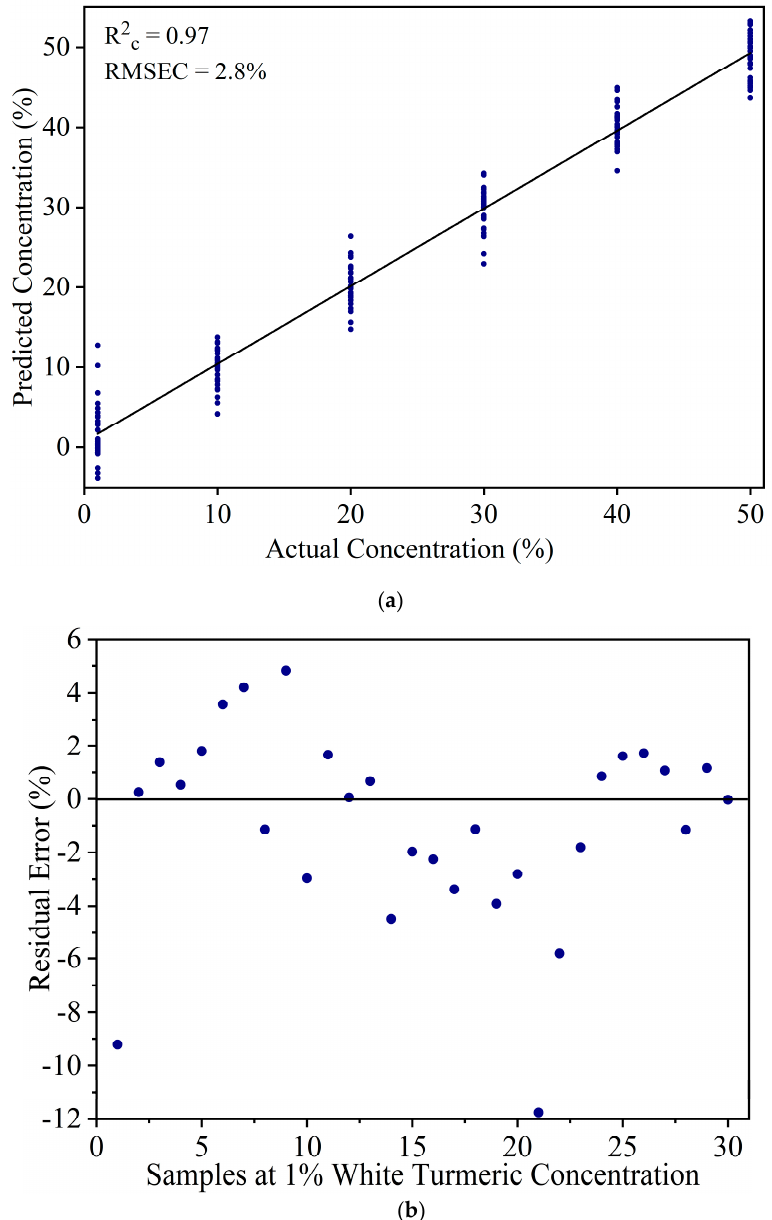
Figure 5. ( a ) Result of the calibration model to estimate white turmeric concentration. ( b ) The residual error for the calibration model of white turmeric at a 1% concentration.